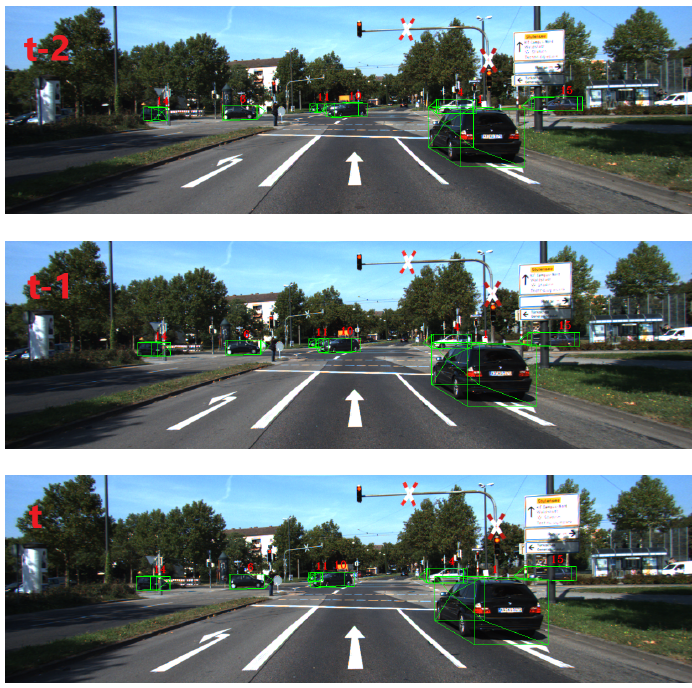
Figure 5. Qualitative results on the KITTI object tracking benchmark validation